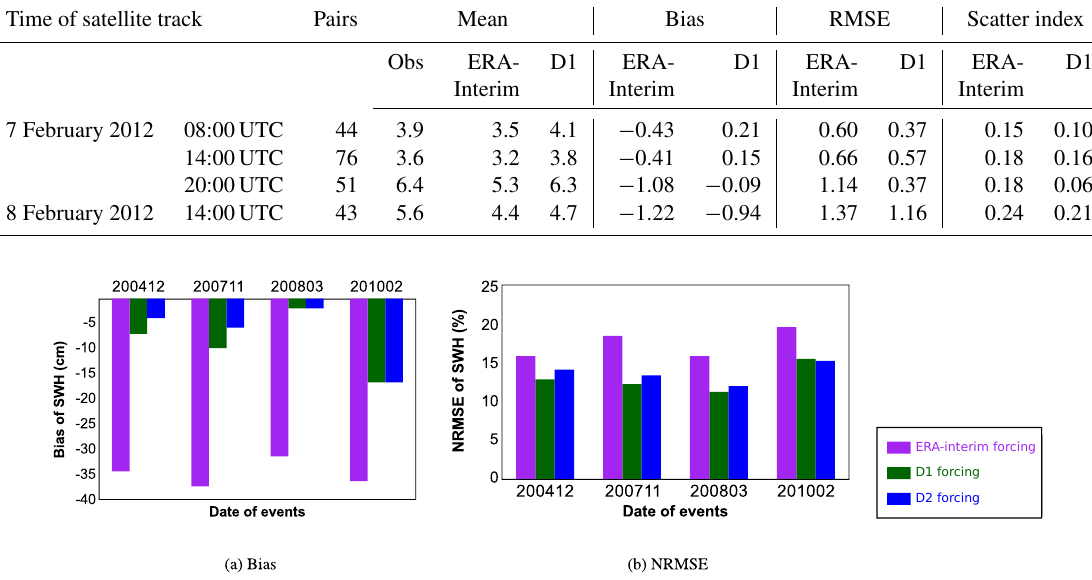
Table 5. Comparison of SWAN wave model significant wave heights (SWHs; metres) and altimeter data from ENVISAT and Jason-1 satellites for the 2012 case over the Bulgarian coast. Time of satellite track